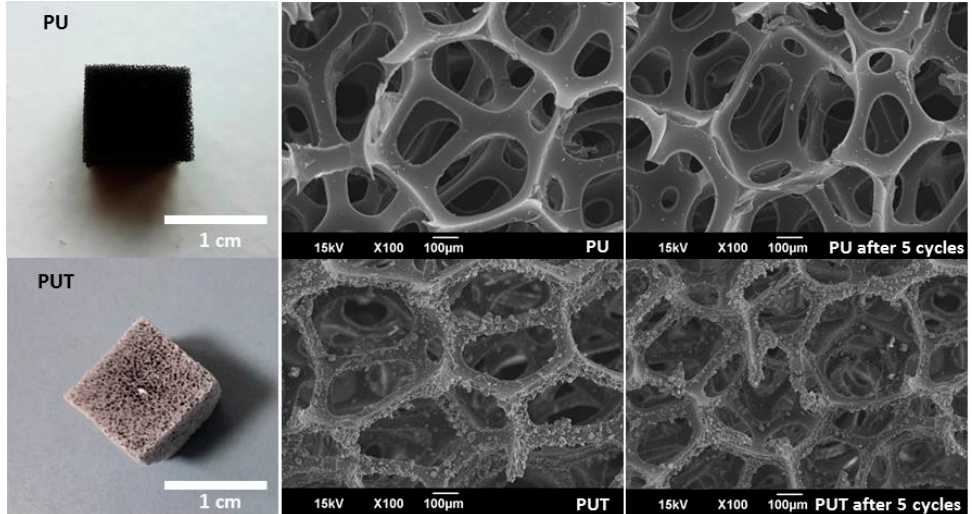
Figure 2. Photographs ( left ) of PU ( up ) and treated PU foams (PUT) ( down ) foams, and SEM micrographs of their porous structure before ( middle ) and after five washing cycles with ethanol ( right ).